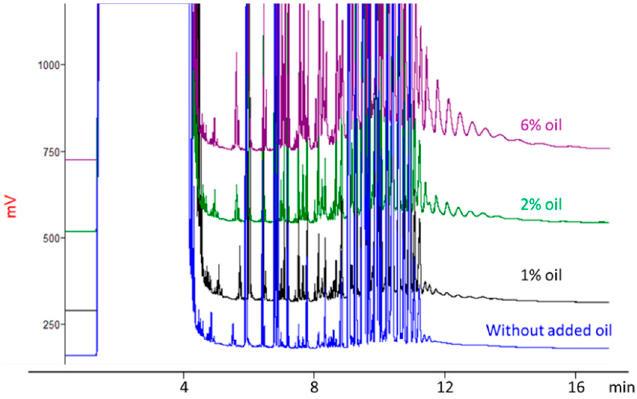
Figure 7. E ff ect of di ff erent oil content on POH migration. Figure 7. Effect of different oil content on POH migration.